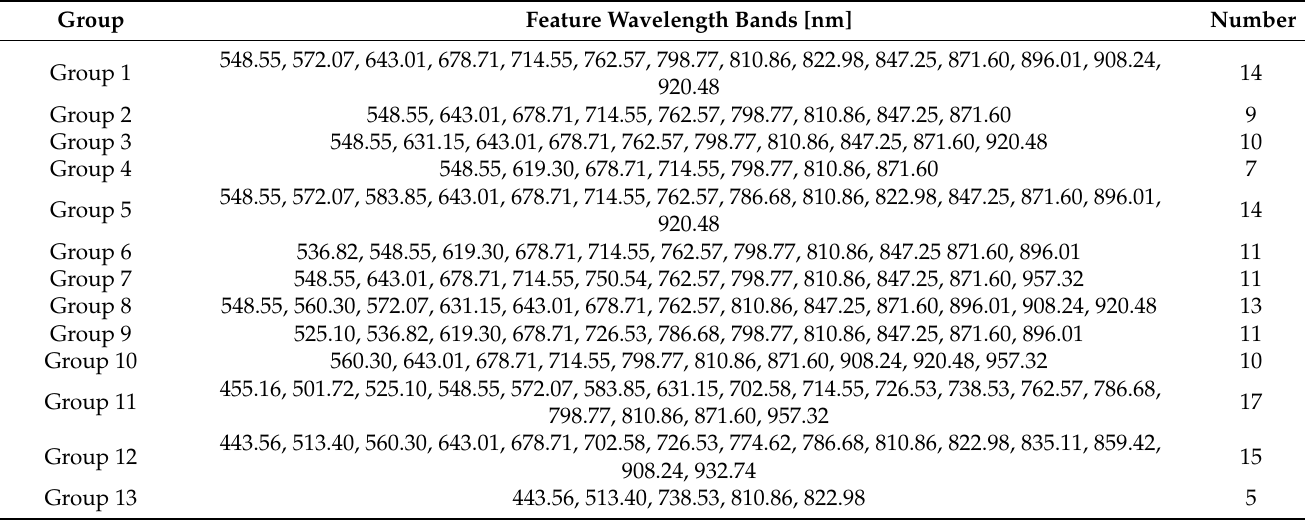
Table 2. The results of feature wavelength bands selected using SNV data under different adulteration groups.